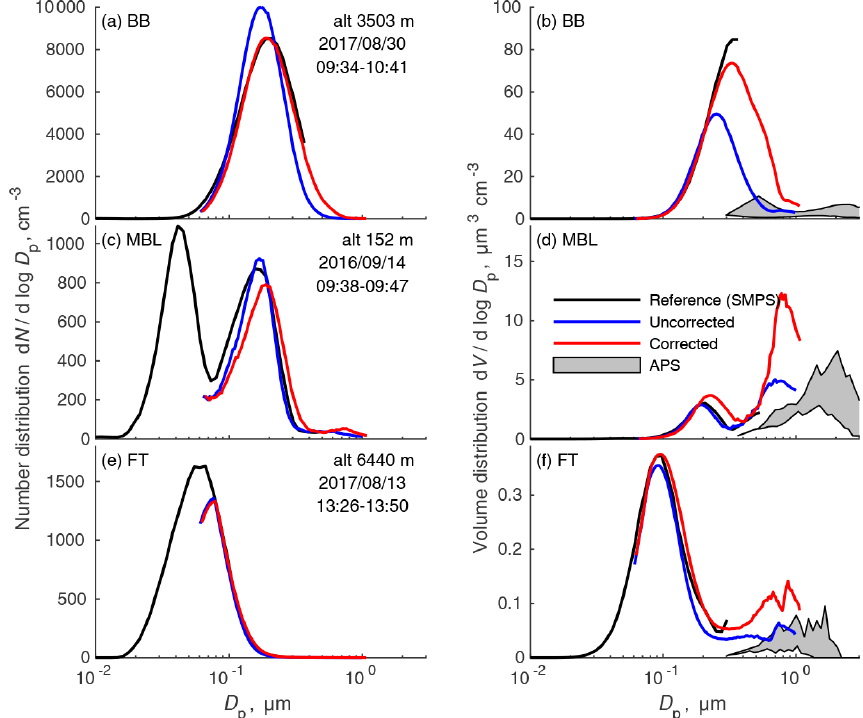
Figure 11. Examples of the proposed correction on samples from the polluted FT (a, b) , a clean MBL (c, d) , and above the plume in the clean FT (e, f) . Plots on the left are number distributions, and those on the right are volume distributions, which emphasize the larger particles. Since we do not know the density, the APS data are shown as a shaded region between assumed densities of biomass burning aerosol (1.2gcm − 3 ) and dust (3gcm − 3 ) in panels (b) and (f) or sea salt (2.2gcm − 3 ) in (d)